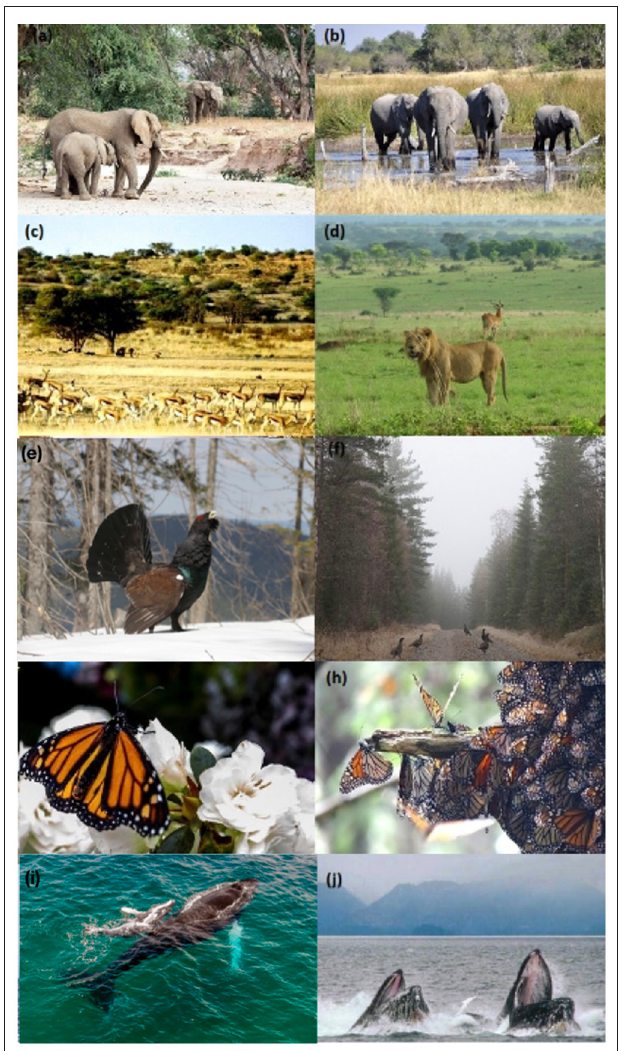
FIGURE 1 | Experiencing biodiversity at one site is not the same as experiencing it at others. Photo (a) shows the different experiences people have in viewing African elephants Loxodonta africana trying to eke out a living in the Namib Desert of Namibia compared to the waterworld of Botswana’s Okavango Delta (b) . Photo (c) shows a pride of lions Panthera leo feasting on a springbok Antidorcas marsupialis beneath a camel thorn acacia Vachellia erioloba tree on the dry bed of the Nossob River in the Kalahari Gemsbok National Park, while (d) shows a lion set amongst the emerald green grasslands of Murchison Falls National Park. Experiencing capercaillie lek in mountain meadows in the Black Forest (e) is vastly different from that in Scotland’s coniferous forests (f) . Watching a solitary monarch butterfly as it starts its migration in Quebec (g) is not comparable to watching it when it joins conspecifics in Mexico (h) . Observing a humpback whale pod on their migration to their calving grounds in the tropics (i) is a substantially different experience from watching a pod lung feed in polar regions (j) . Photo credits: (a) Greg Willis; (b) pixabay.com; (c) Matt and Gina Hayward; (d) Wikipedia Commons; (e) Jean Meyer; (f) Wikipedia Commons; (g) Flickr; (h) Wikipedia Commons; (i) Eduardo Estrada; and (j) Wikipedia.